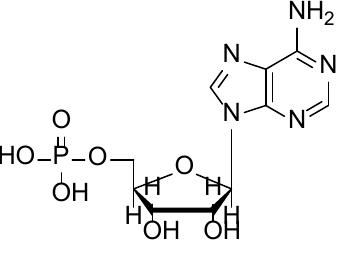
Figure 1 : Structure of adenosine monophosphate(AMP).